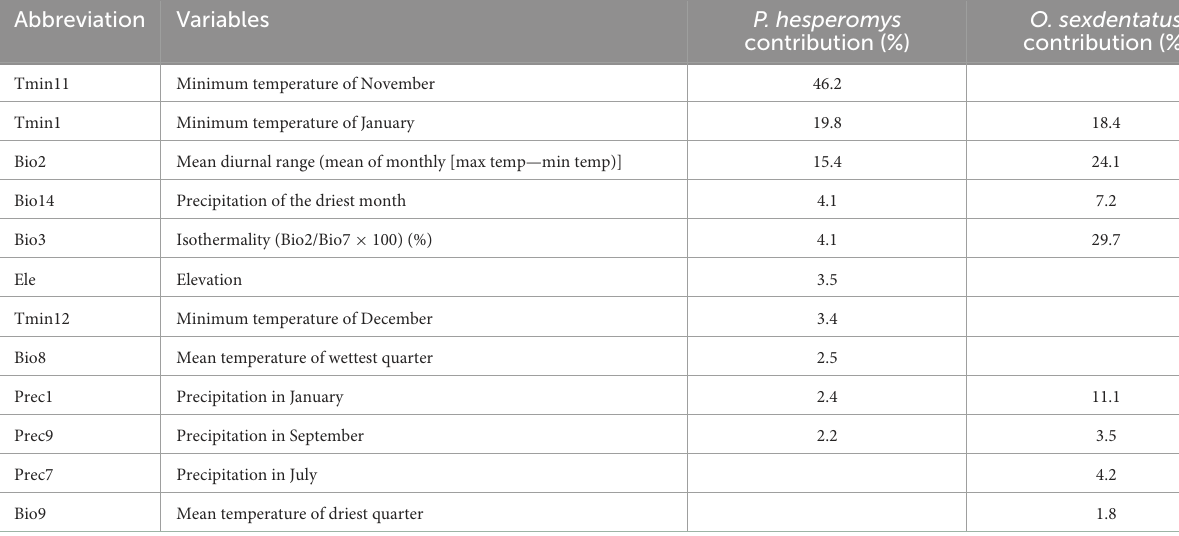
TABLE 1 Percentage contributions of environmental variables in Maxent for P. hesperomys and O. sexdentatus